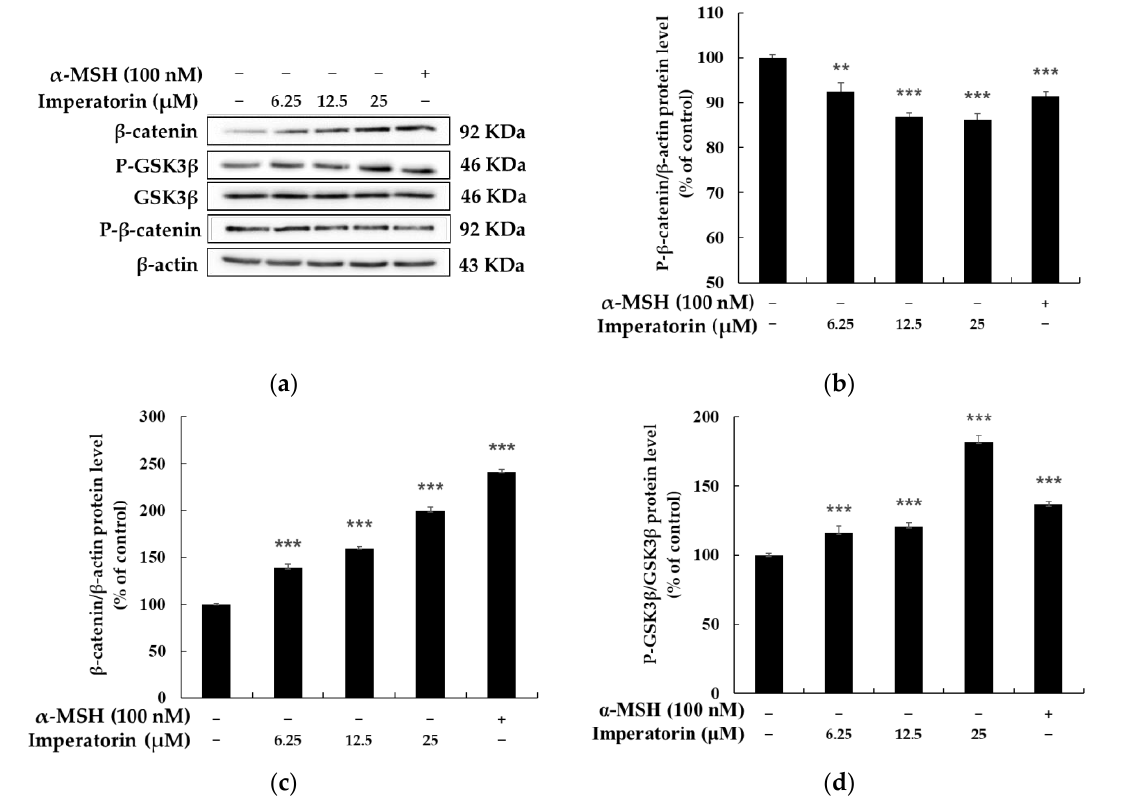
Figure 8. The effects on the protein expression of β -catenin, P-GSK3B, and P- β -catenin in B16F10 melanoma cells when the cells were treated with imperatorin (25, 12.5, and 6.25 μM) for 24 h: ( a ) Western blotting results; protein levels of ( b ) P- β -catenin, ( c ) β -catenin, and ( d ) P-GSK3 β . β -Actin was used as a loading control. The results are presented as the mean ± SD from three independent measurements using ImageJ software. ** p < 0.01 and *** p < 0.001 vs. the untreated control group.